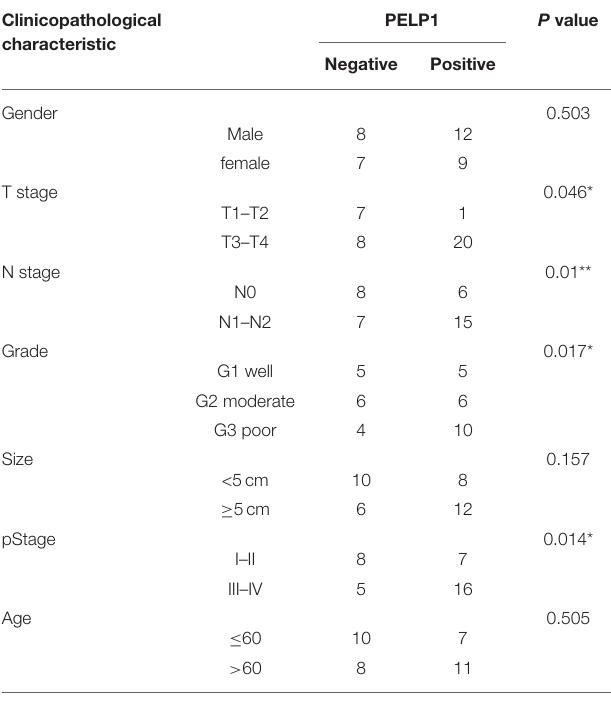
TABLE 4 | Relationship between clinicopathological characteristic and PELP1 expression in gastric